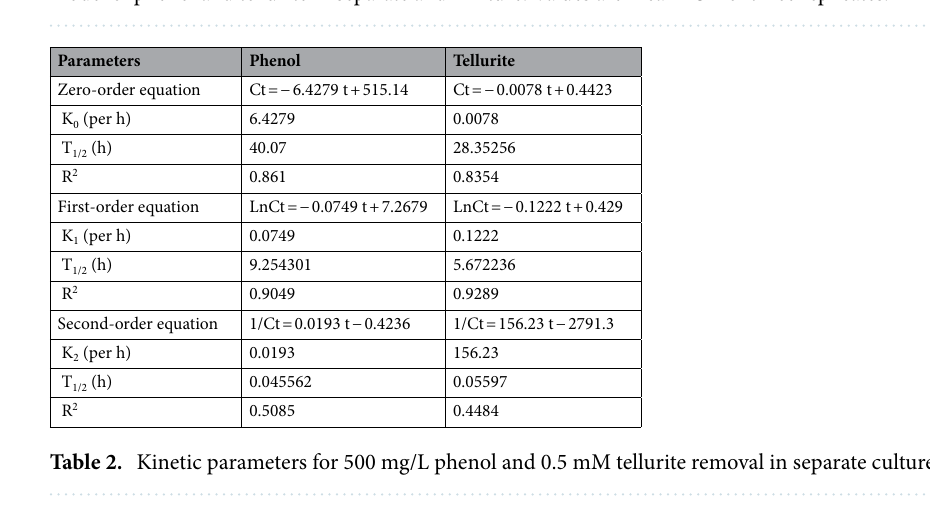
Figure 3. ( a – c ) the growth rate and remediation yield of Lysinibacillus sp . EBL303, respectively, in phenol (500 mg/L), tellurite (0.5 mM), and phenol (500 mg/l)/tellurite (0.5 mM) mixture; ( d ) the first-order removal model of phenol and tellurite in separate and mixture. Values are mean ± SD of three replicates.